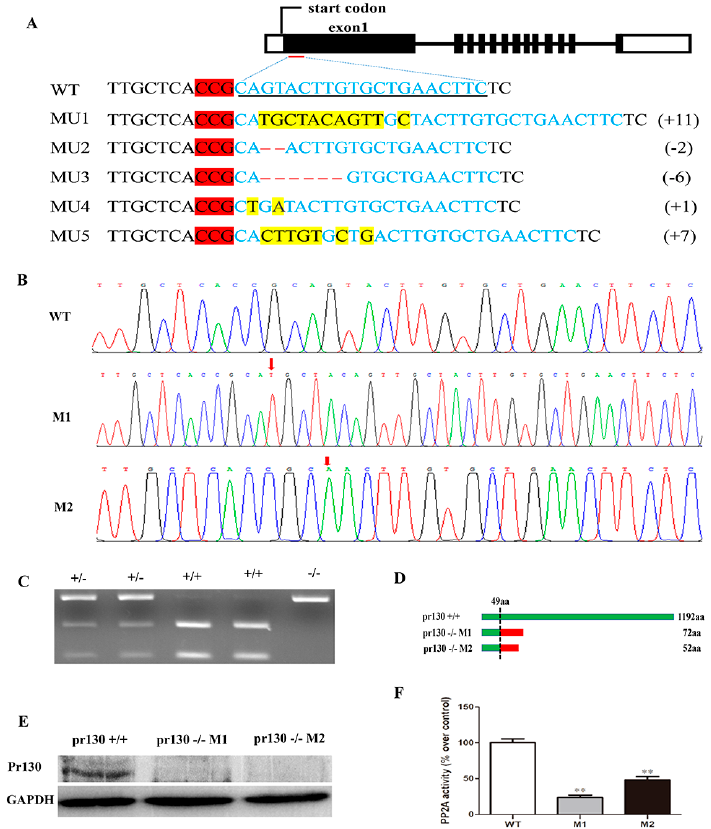
Figure 2. Schematic diagram of pr130 knock-out in zebrafish using CRISPR/Cas9 system and analysis of PP2A activity. ( A ) Sequence of target site is underlined with black line and is shown in blue font in wild-type (WT) and protosacer adjacent motif (PAM) highlighted in red. Deletions and insertions are indicated by dashes and yellow highlight, respectively. Changed nucleotides are shown on the right side, “+” indicates insertion and “ − ” indicates deletion; ( B ) The sequences of WT, M1 and M2, the regions of insertion (M1) and deletion (M2) are indicated by red arrows; ( C ) A representative genotyping of ScaI digestion of PCR products amplified from genomic DNA, the products amplified from WT samples could be digested completely, whereas those of the homozygous mutants could not be digested, and those of the heterozygous mutants could be partially digested. +/+ indicates WT, (+/ − ) indicates heterozygous mutants, ( − / − ) indicates homozygous mutants; ( D ) The predicted amino acids of Pr130, in which showed a truncated protein, the first 49 aa ( green ) are identical to those of the WT Pr130 protein, which contains 23 (M1) or 3 (M2) miscoding amino acids ( red ); ( E ) Western blotting analysis of Pr130 protein; ( F ) PP2A activity was determined in cardiac extracts of WT and mutants. Data represent the mean ± SD. The symbols ** in the bar chart represent significant differences ( p < 0.01).